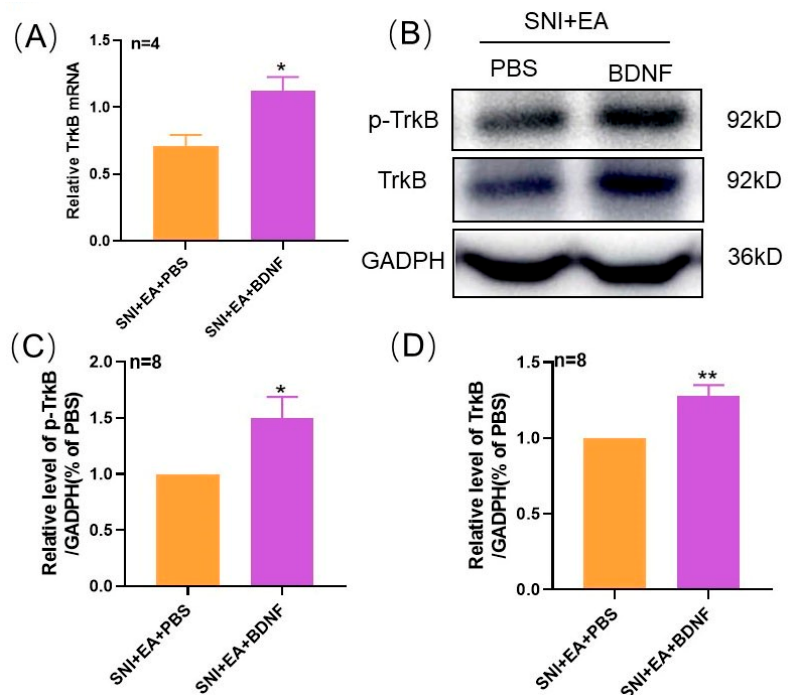
Figure 5. Effect of exogenous BDNF or PBS on spinal p-Tr κ B and Tr κ B protein expression induced by 2 Hz EA in SNI rats. ( A ) Relative levels of Tr κ B mRNA expression ( n = 4 per group). ( B )